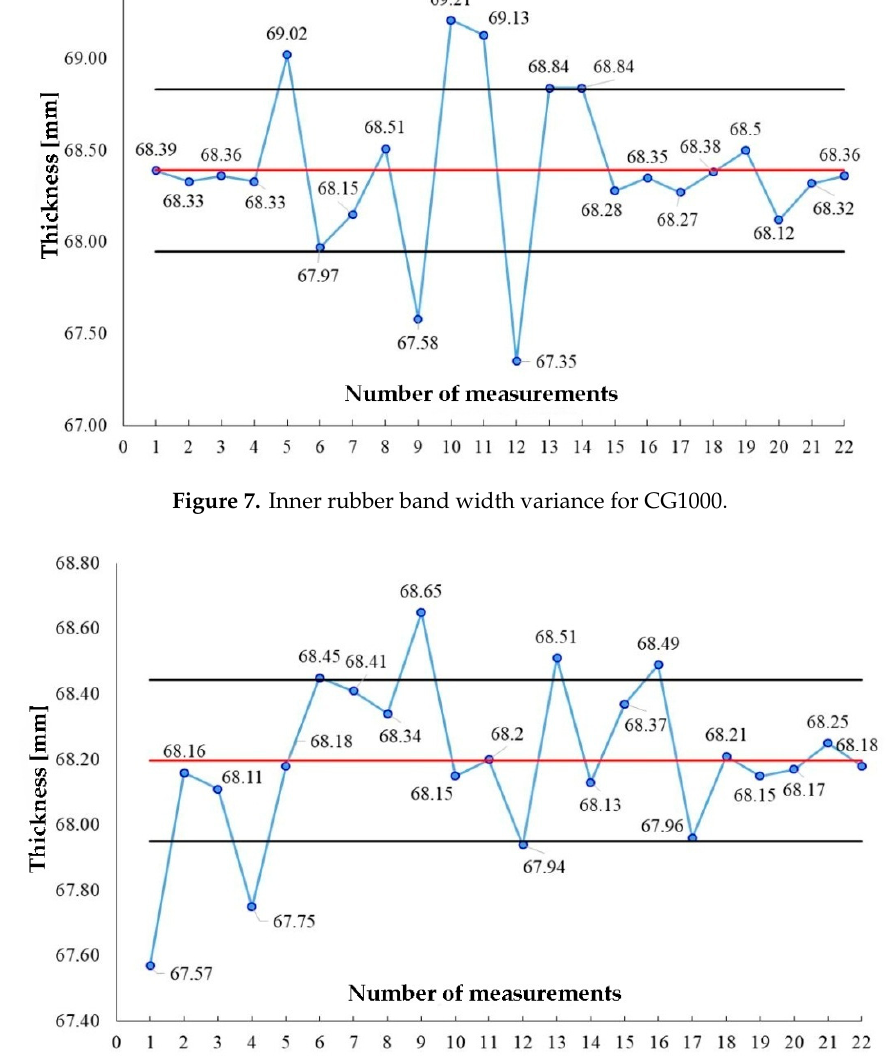
Figure 8. Inner rubber band width variance for CG1500.